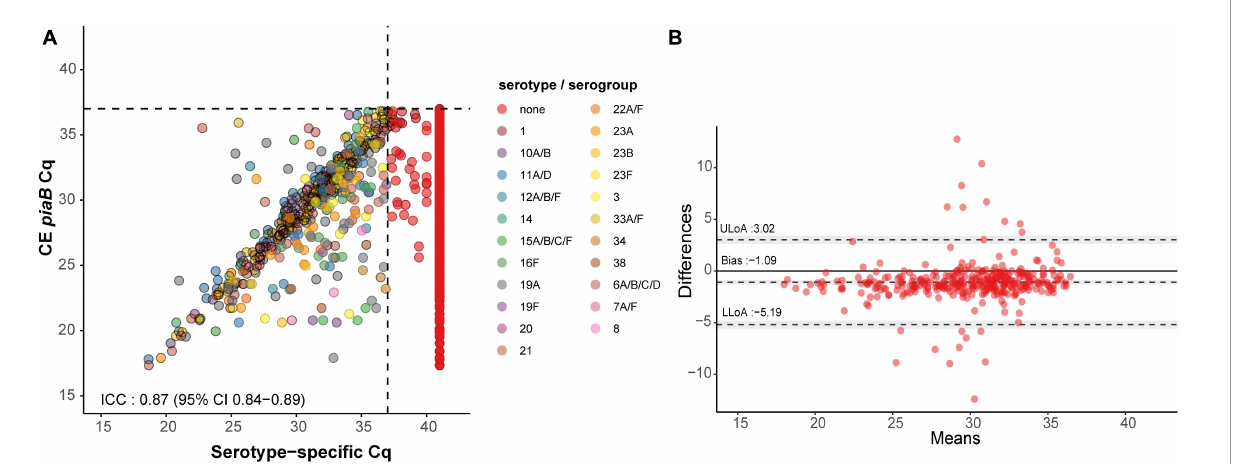
FIGURE3 Scatter plot (A) illustrating extent of agreement between piaB and serotype/serogroup-specific detection among culture-enriched saliva samples ( n = 353) and Bland–Altman plot (B) displaying extent of agreement and bias among samples with C q s < ROCd C q for piaB and serotype/serogroup-specific qPCR assays. In panel (A) , saliva samples are colored by serotype/serogroup-specific signal detected. Samples classified as negative for any of the tested serotype/serogroup-specific qPCR assays are colored in red. Black dashed lines indicate data-driven ROCd C q thresholds. In panel (B) (Bland–Altman plot) the degree of agreement between piaB and lytA C q measurements among positive samples is shown. The mean difference in measurements is indicated by a dashed gray line and the standard deviations of the mean, upper limit of agreement (ULoA) and lower limit of agreement (LLoA) are also shown. Shaded areas indicate the 95% confidence interval. The solid black line indicates the line of equality (no bias) and dots above this line are for samples of which lytA C q s where lower than piaB C q s. ICC values < 0.50, 0.50–0.75, 0.75–0.90, and ≥ 0.90 are indicative of poor, moderate, good, and quantitative agreement,